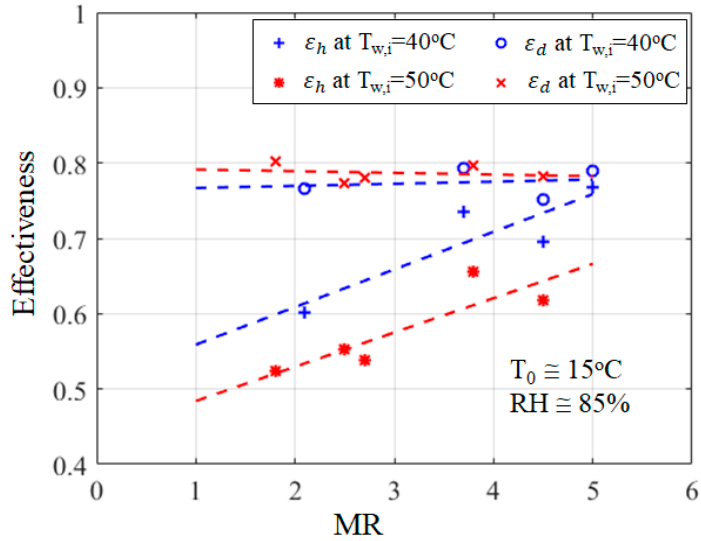
Figure 9. Humidifier e ff ectiveness ε h and dehumidifier e ff ectiveness ε d as a function of MR .